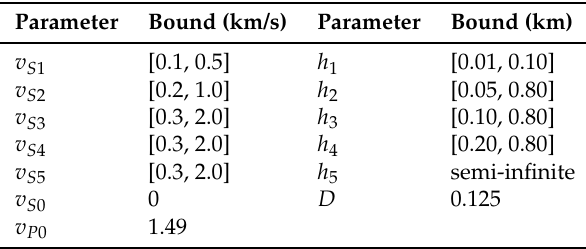
Table 2. Search bound of seabed